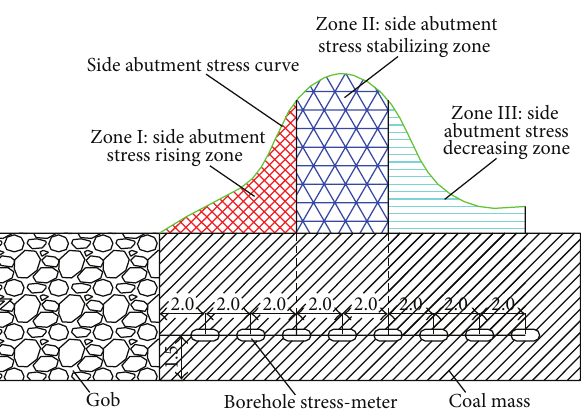
Figure 4: Zone chart of the distribution of the side abutment stress.